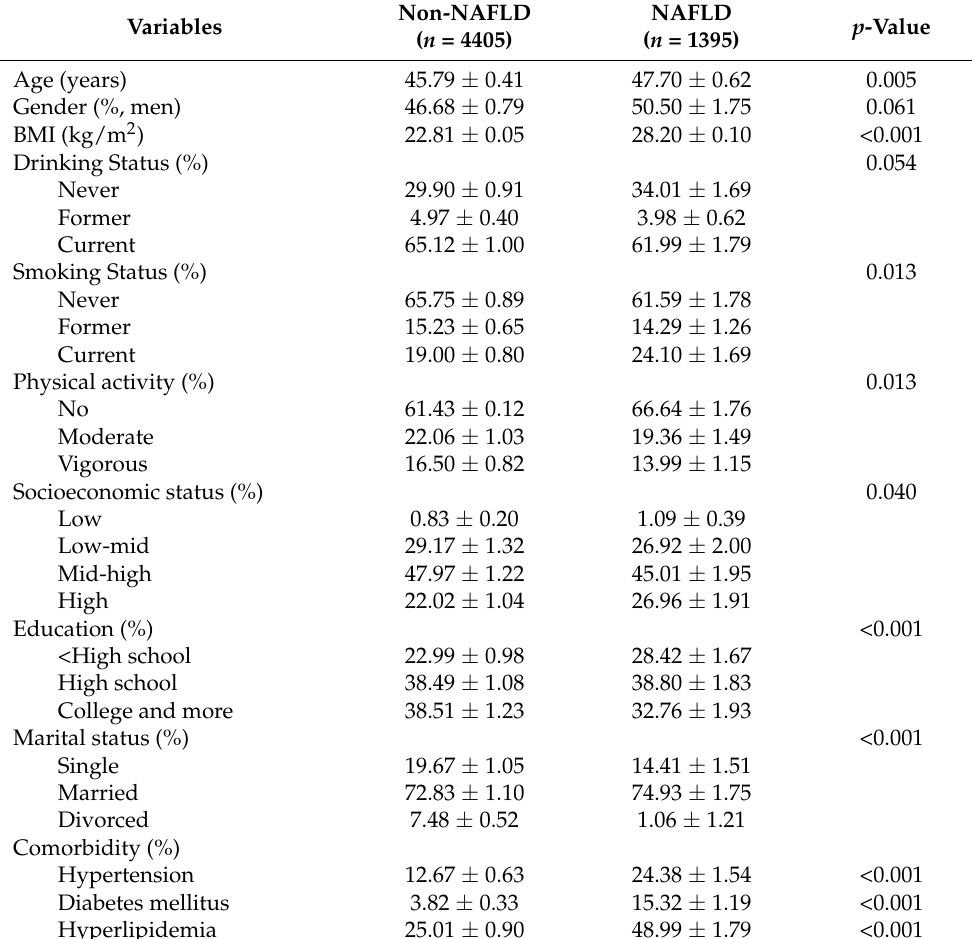
Table 1. General characteristics of study participants according to the hepatic steatosis index score. Non-NAFLD Variables